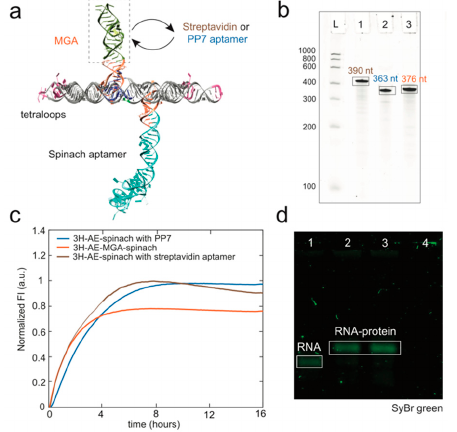
Figure 5. ( a ) schematic representation of 3H-AE-MGA-Spinach RNA tile without 120° KL. The MG aptamer can be modularly replaced by other RNA aptamers as indicated; ( b ) denaturing PAGE gel showing the length of 3H-AE-Spinach with different secondary aptamer modifications. L: LowRange RiboRuler, 1: 3H-AE-Spinach with streptavidin aptamer (390 nt), 2: 3H-AE-Spinach with PP7 aptamer (363 nt), 3: 3H-AE-MGA-Spinach (376 nt); ( c ) real-time fluorescence of DFHBI during transcription of RNA tiles containing different aptamers; ( d ) native agarose gel (2% agarose in 1X tris-borate EDTA (TBE) buffer + 2 mM MgCl 2 ) stained with SyBr Green showing the retardation of RNA tile containing